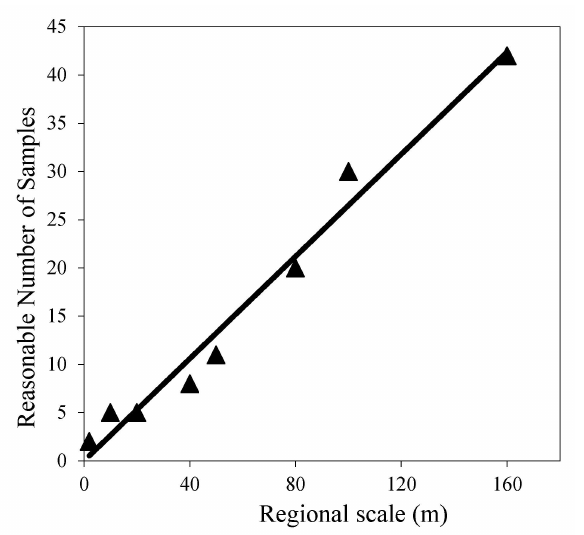
Figure 6. Relationship between the R n and the regional scale at a relative error of 10% and a confidence level of